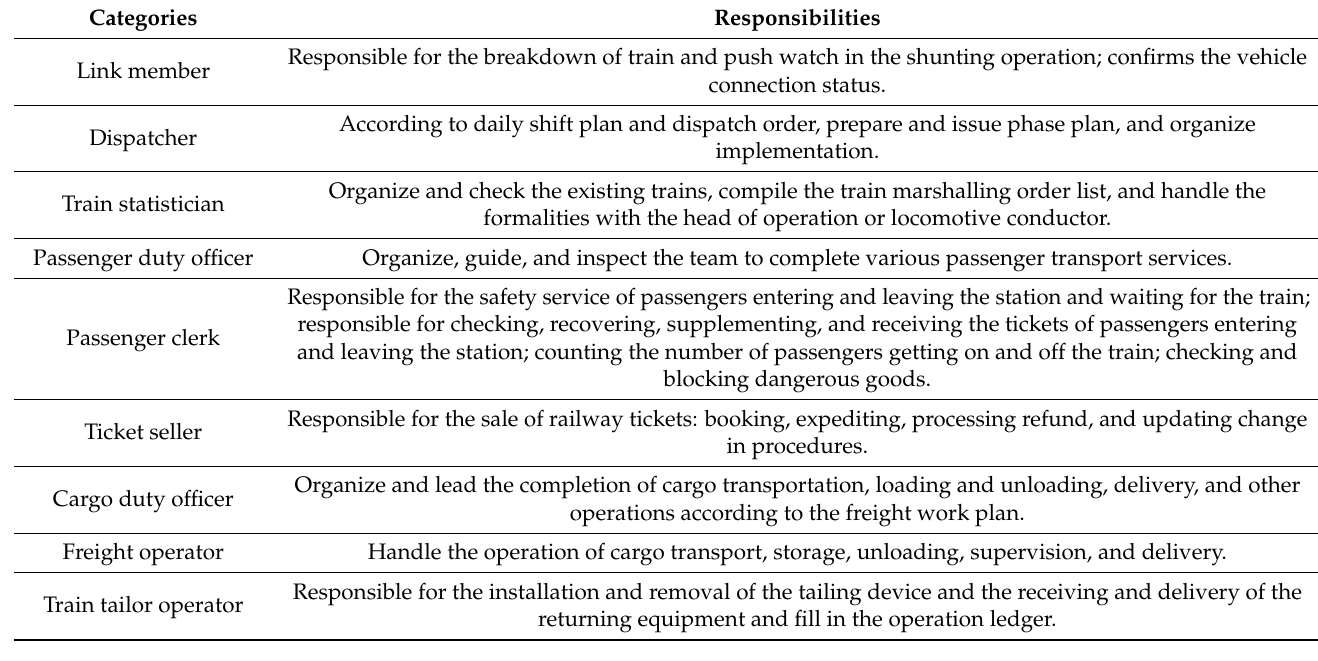
Figure 3. Code structure of the train operation department grid.